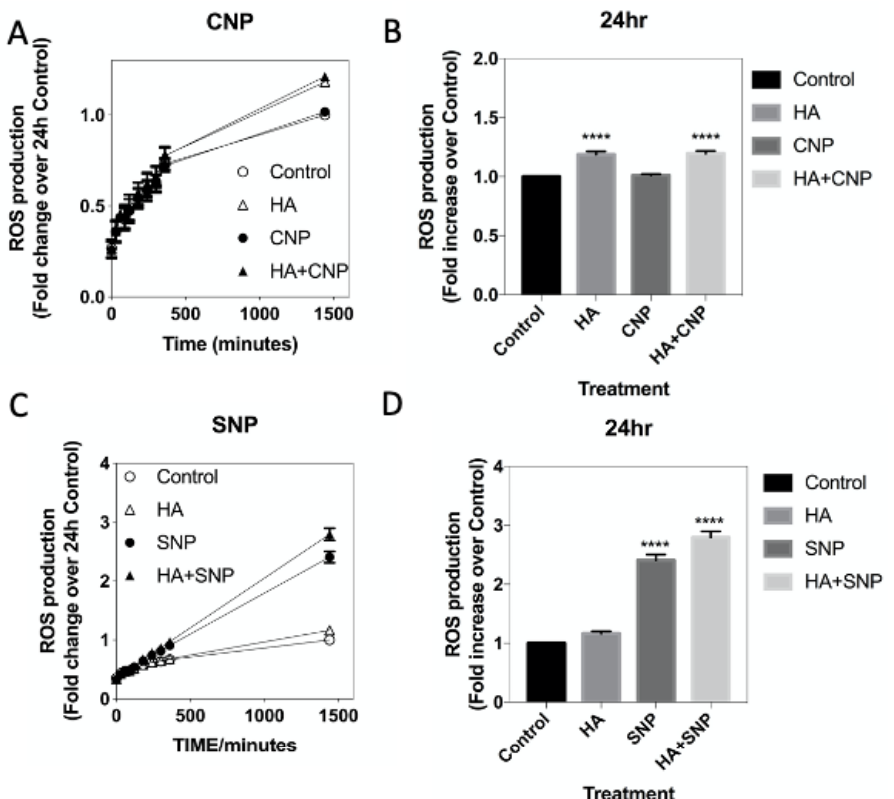
Figure 7. ( A – D ). Effects of hyperammonaemia on ROS production in rat C6 glioma cells. Cells were pre-treated in media containing 1% ( v / v ) FCS and 100 µ M DHR for 30 min prior to stimulation with either 0, 10 mM NH 4 Cl (HA), 100 nM CNP, 1 mM SNP, or combinations of HA+CNP and HA+SNP. ROS production was measured every 30 min for 6 h on a plate-reading spectrophotometer at 500 nm, with a final reading taken after 24 h. The data shown are means ± SEM, pooled from 4 to 6 independent experiments, each performed with 16 replicates ( n = 4 to n = 6), and normalised to the 24 h control reading. **** p < 0.0001, significantly different from control.